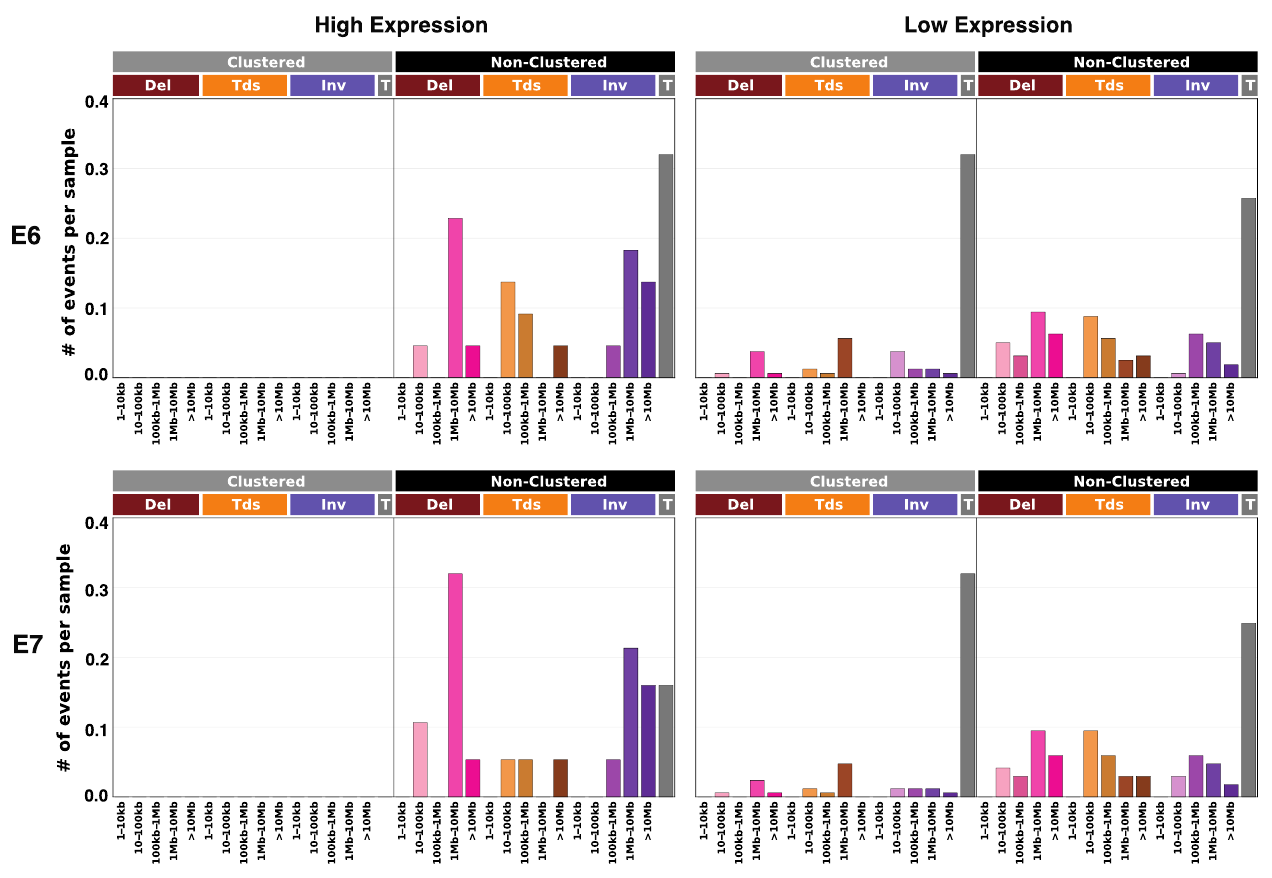
Figure 4. E6/E7 expression correlation to structural variation. Bar plots of the average number of variances across samples by E6/E7 high expression and low expression. Both clustered and non-clustered events are shown, classified as deletions (Del), tandem duplications (Tds), inversions (Inv), and translocations (T). Patients were categorized by individual E6/E7 TPM, with TPM ≥ 10 considered high expression, and TPM < 10 low expression.